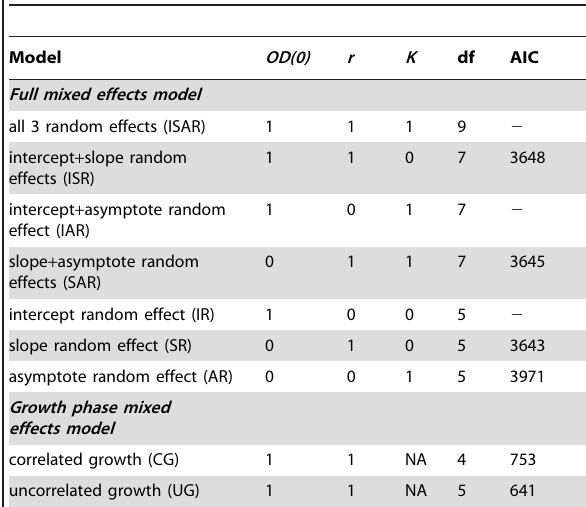
Table 1. Mixed effects model